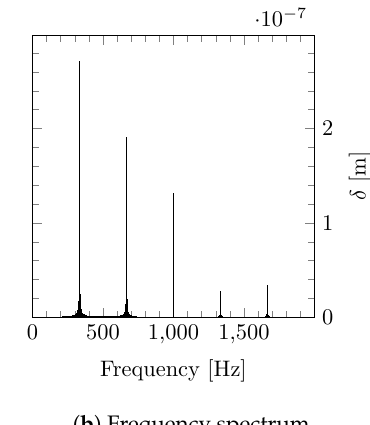
Figure 9. Numerical results for the dynamic transmission error δ for the gear system discussed by Zhou et al. [28]. Subplot ( a ) shows the obtained transient results. Due to the constant operating speed, the TE frequency spectrum is characterized by narrow banded peaks at the gear meshing frequency orders, see subplot ( b